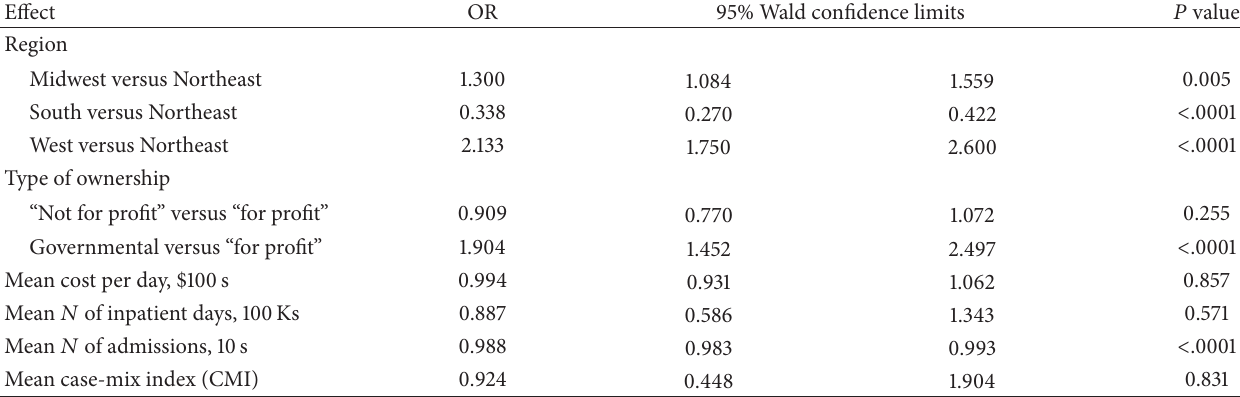
Table 2: Multivariate analysis: facility odds of having high MS volume (defined by pct MS days > 3%).